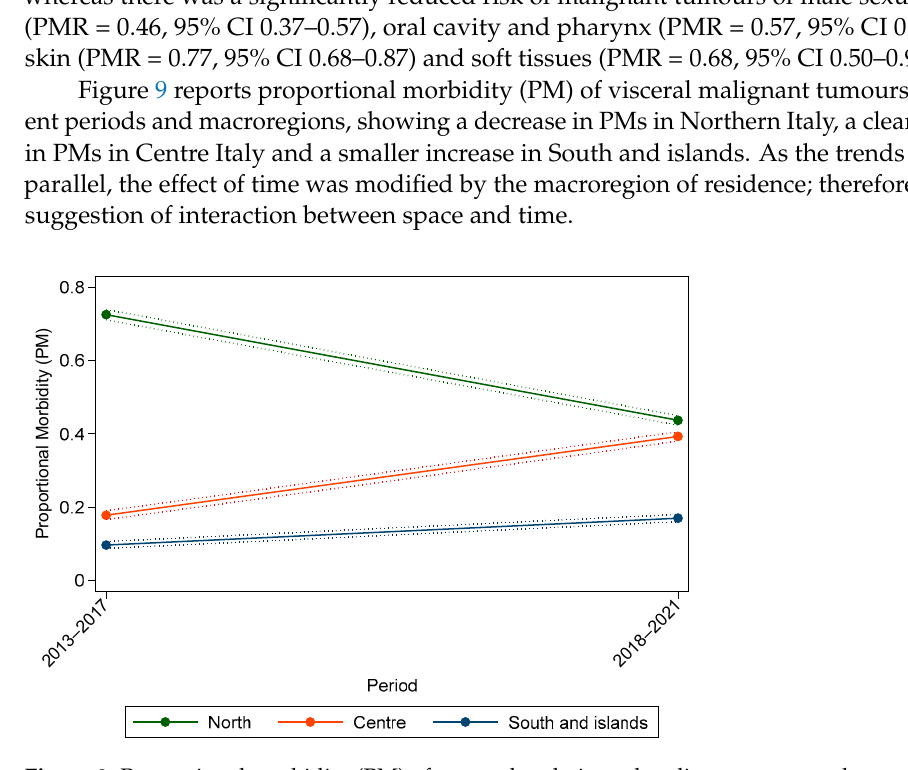
Figure 9. Proportional morbidity (PM) of external and visceral malignant tumours by macroregions (solid lines) and their 95% confidence interval (dotted lines).